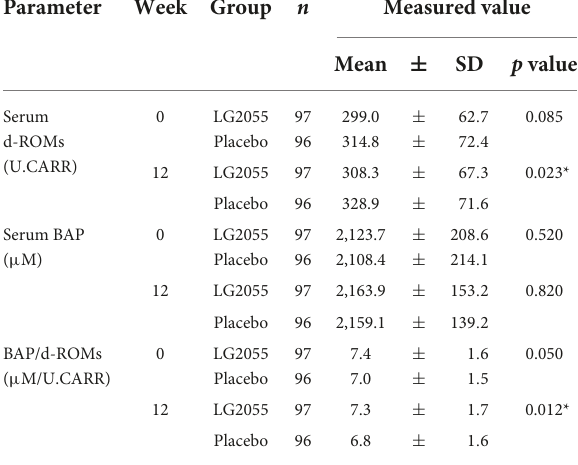
TABLE 5 Measured values of oxidative markers during the intake period. Parameter Week Group